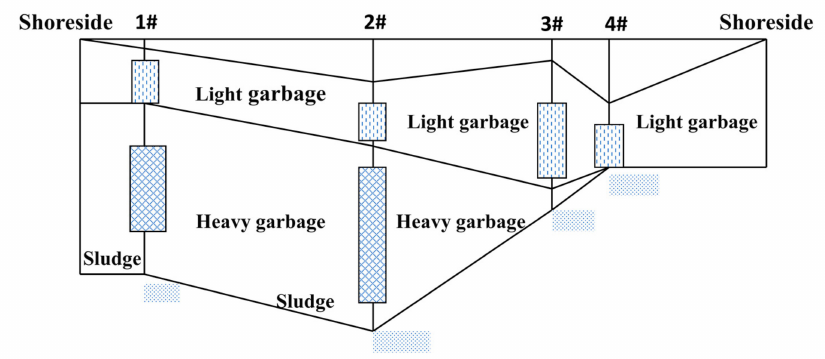
Figure 2. Geophysical